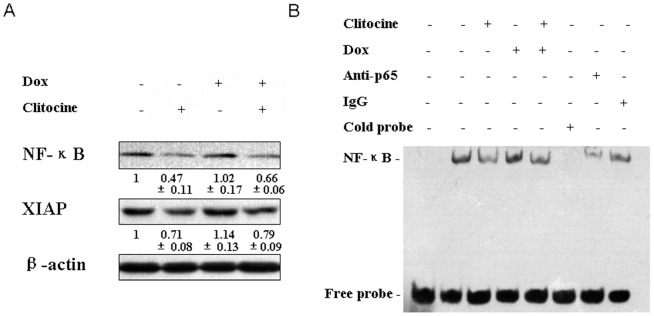
Clitocine inhibits the expression of XIAP and activation of NF-κB in R-HepG2 cells.(A) After treatment with 0.2 µM clitocine, 1.2 µM doxorubicin or combined agents for 48 h, Western blot was performed to assess the expression of NF-κB p65 and its' target mediator XIAP. (B) After treatment with 0.2 µM clitocine, 1.2 µM doxorubicin or combined for 60 min, nuclear protein was extract and analyzed using ESMA with a double-stranded oligo nucleotide probe containing NF-kB consensus sequence. Excess molar ratio of cold probe (lane 6), anti-p65 subunit of NF-kB antibody (lane 7) and IgG (lane 8) were used for the specificity assay.